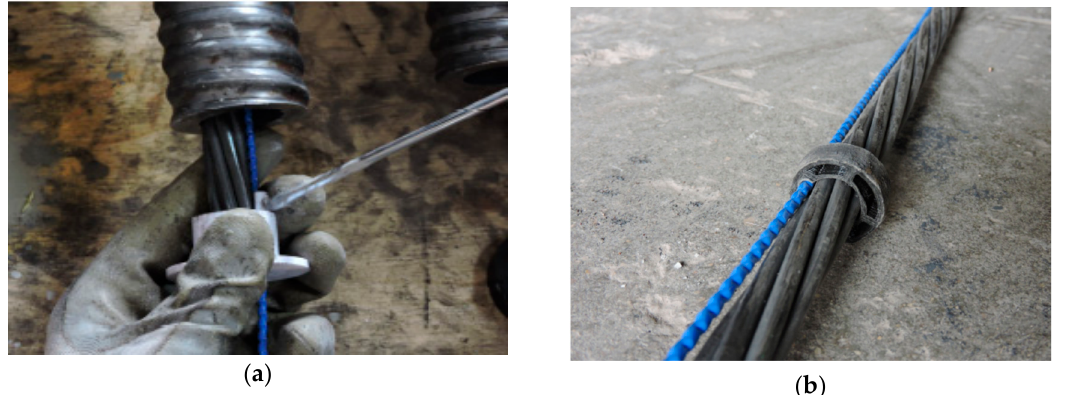
Figure 3. Plastic hooks for coupling the DFOS (distributed fibre optic sensors) to the tendon in a composite bar: ( a ) element for extremity; ( b ) internal